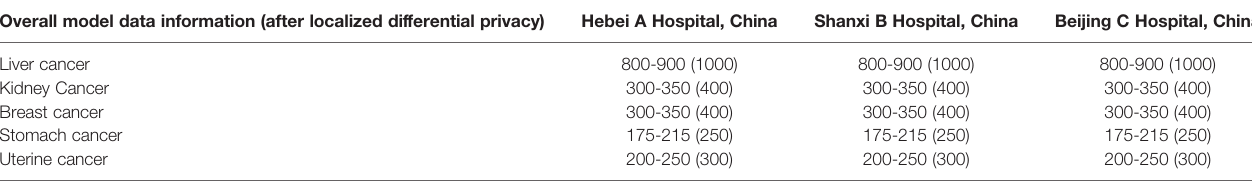
TABLE 4 | Introduction to the data set of participants.